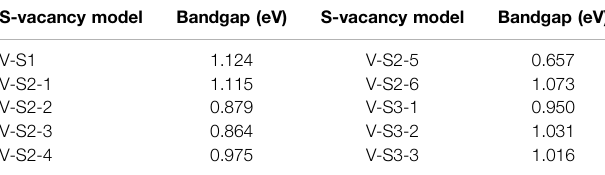
TABLE 1 | Bandgap of different S-vacancy